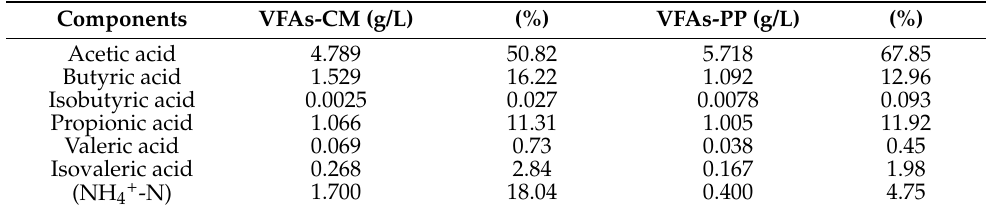
Figure 2. ( a ) Dry cell weight in SVFAs media, ( b ) PHAs in SVFAs media, ( c ) dry cell weight in VFAs-stream media and ( d ) PHAs in VFAs-stream media during cultivation of Pseudomonas oleovorans . Abbreviations: SVFAs = Synthetic volatile fatty acids media; VFAs-stream = Volatile fatty acids-stream media. Table 2. Composition of VFAs-rich streams used in this